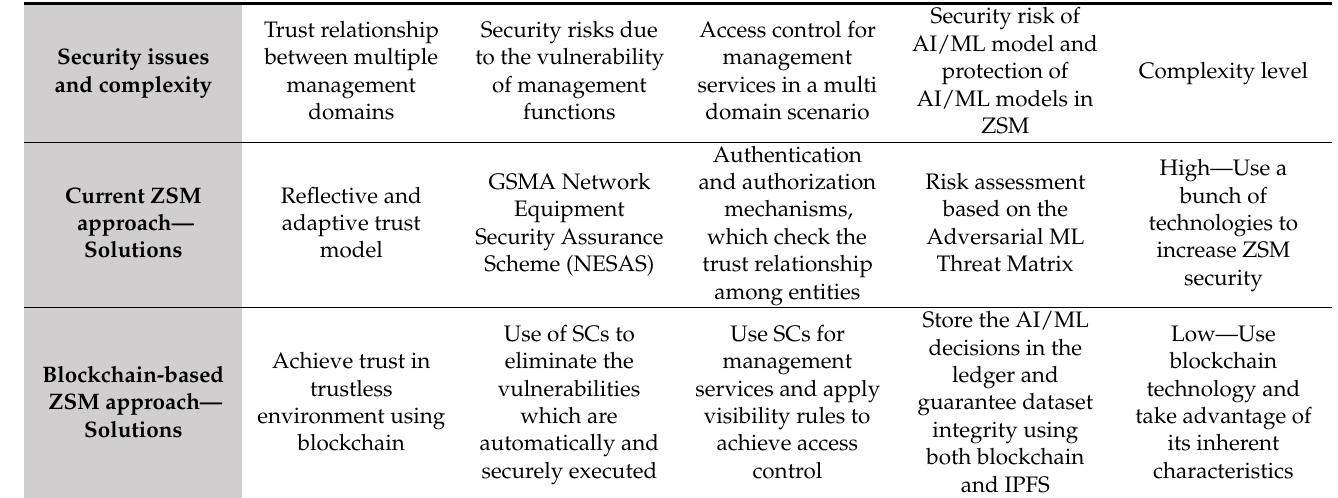
Table 1. Solutions to security issues: Current ZSM vs. Blockchain-based